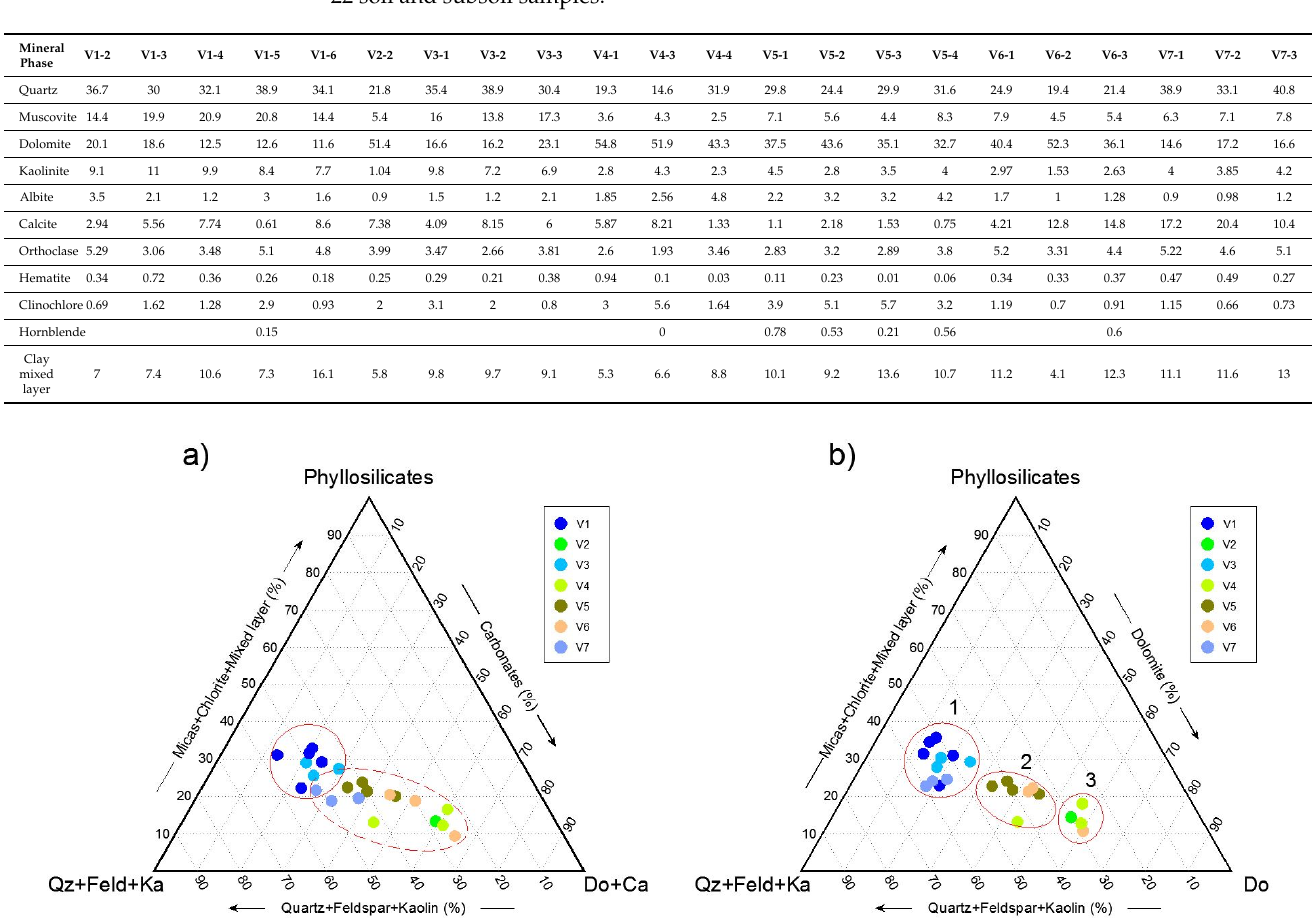
Table 4. Weight fractions (wt%) of the crystalline phases identified by Rietveld refinements in the 22 soil and subsoil samples.